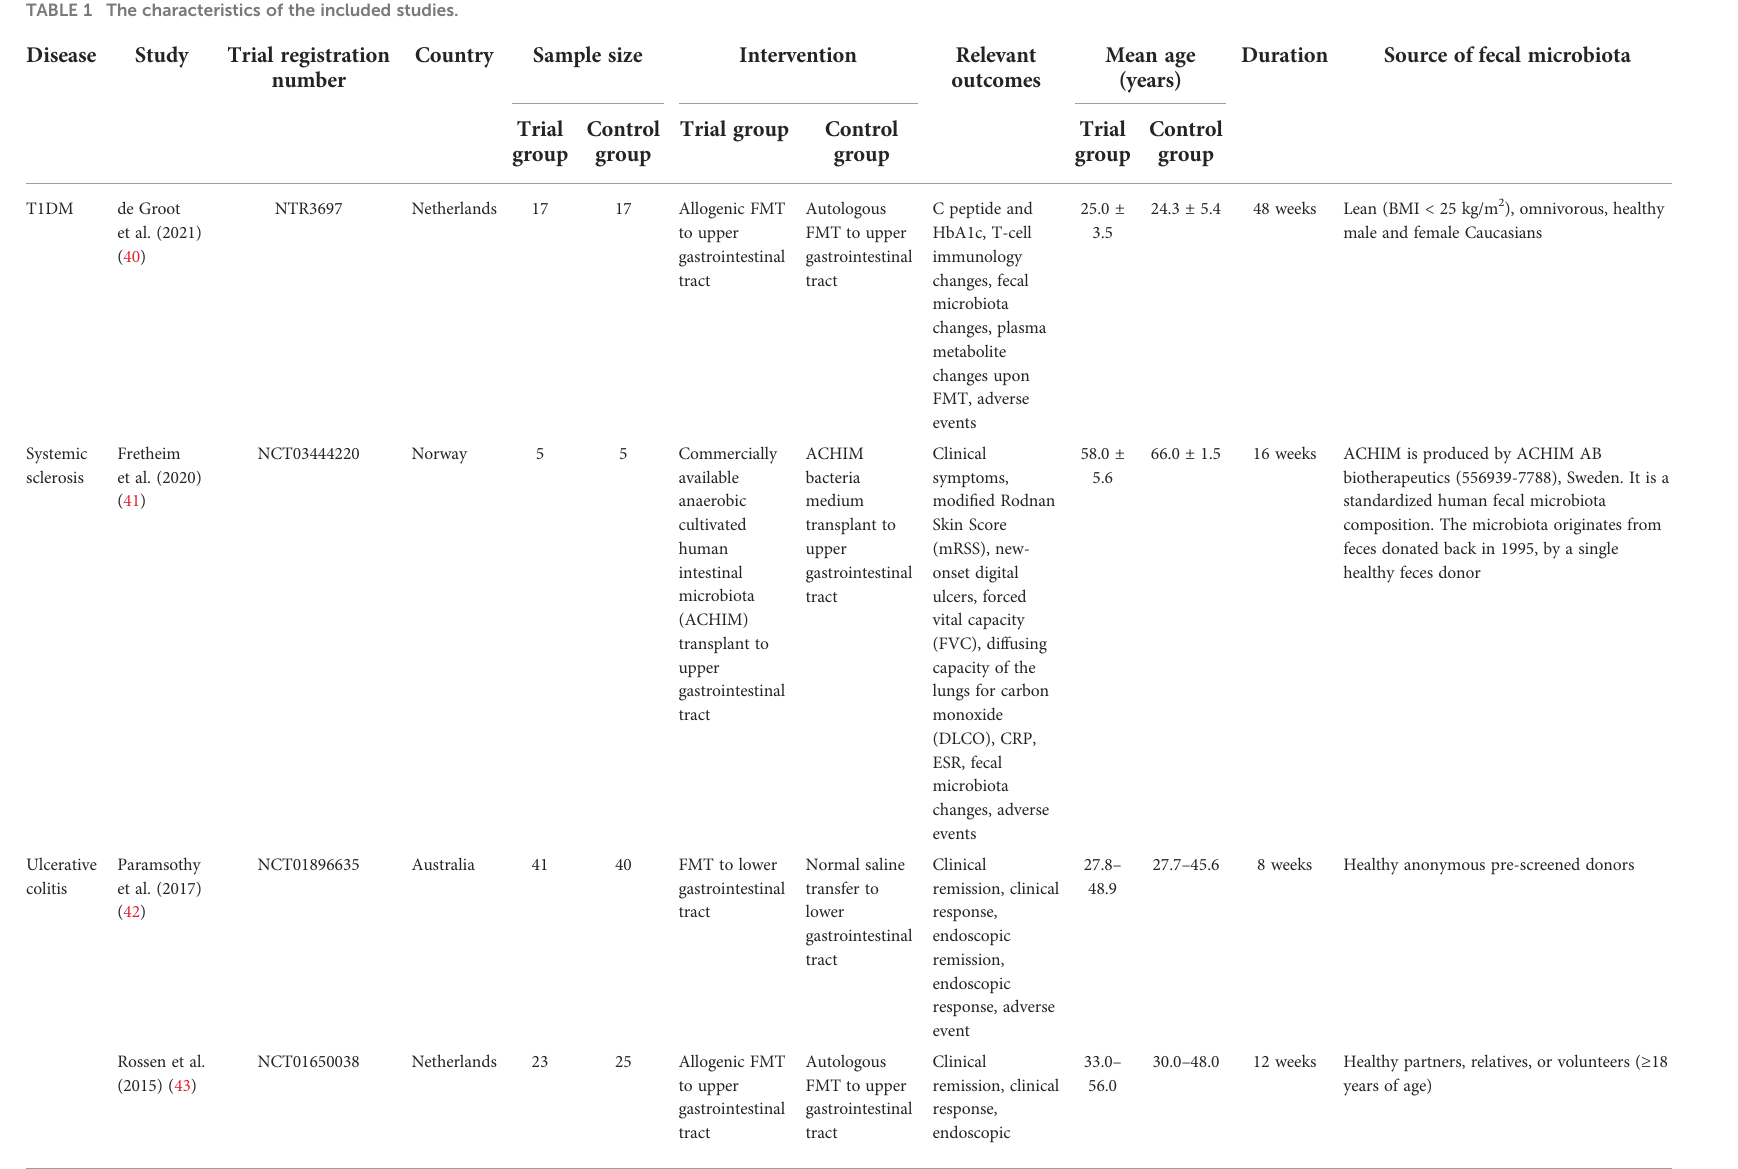
TABLE 1 The characteristics of the included